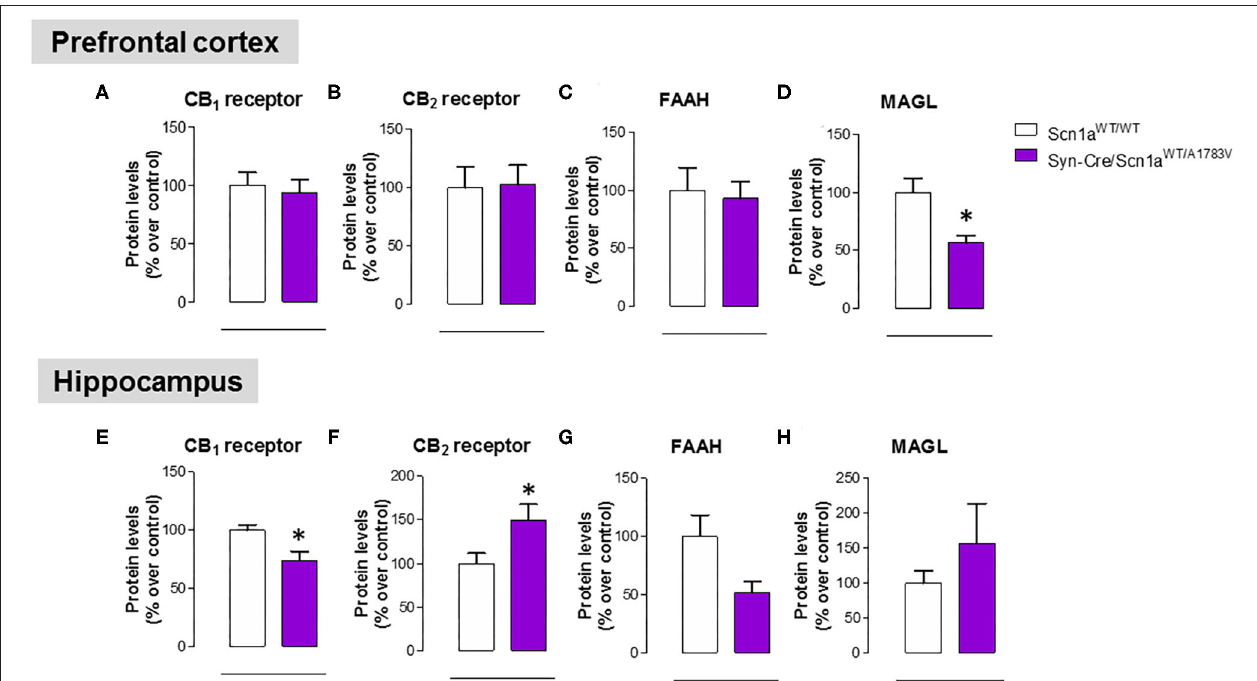
FIGURE 11 | Protein levels for the CB 1 and CB 2 receptors and the FAAH and MAGL enzymes measured by western blot in the prefrontal cortex and the hippocampus of Syn-Cre/Scn1a WT / A1783V mice compared with Scn1a WT / W animals at PND25. Values are % over controls and correspond to means ± SEM of five to six animals per group. Data were assessed by the Student’s t -test (* p < 0.05 vs. the control